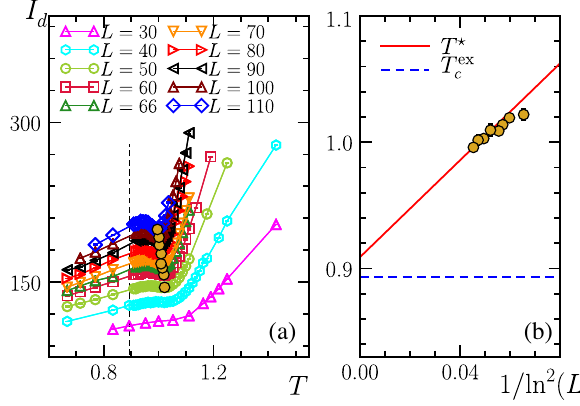
FIG.3. Berezinskii-Kosterlitz-Thoulesstransition.Panel(a)shows the temperature dependence of I d for different values of L . The dashed line indicates the value of the BKT critical temperature obtained in Ref. [55] using conventional methods, T 0 . 8935 ð 1 Þ . For each point, we harvested approximated ten instances of the data set and averaged the resulting estimates for the I d . The error bars are the standard deviation of such results. The scaling collapse obtained with these data sets is depicted in Fig. 1(c). Panel (b) shows the finite-size scaling of T (cid:4) based on Eq. (11). Fitting the results for L ¼ 80 , 90, 100, and 110, we obtain T 0 . 909 (cid:3) 0 . 015 . In the text, we discuss how we obtain the BKT ¼ local minimum of I d , T (cid:4) . We compute the I d of manifolds with N 5 × 10 4 r ¼